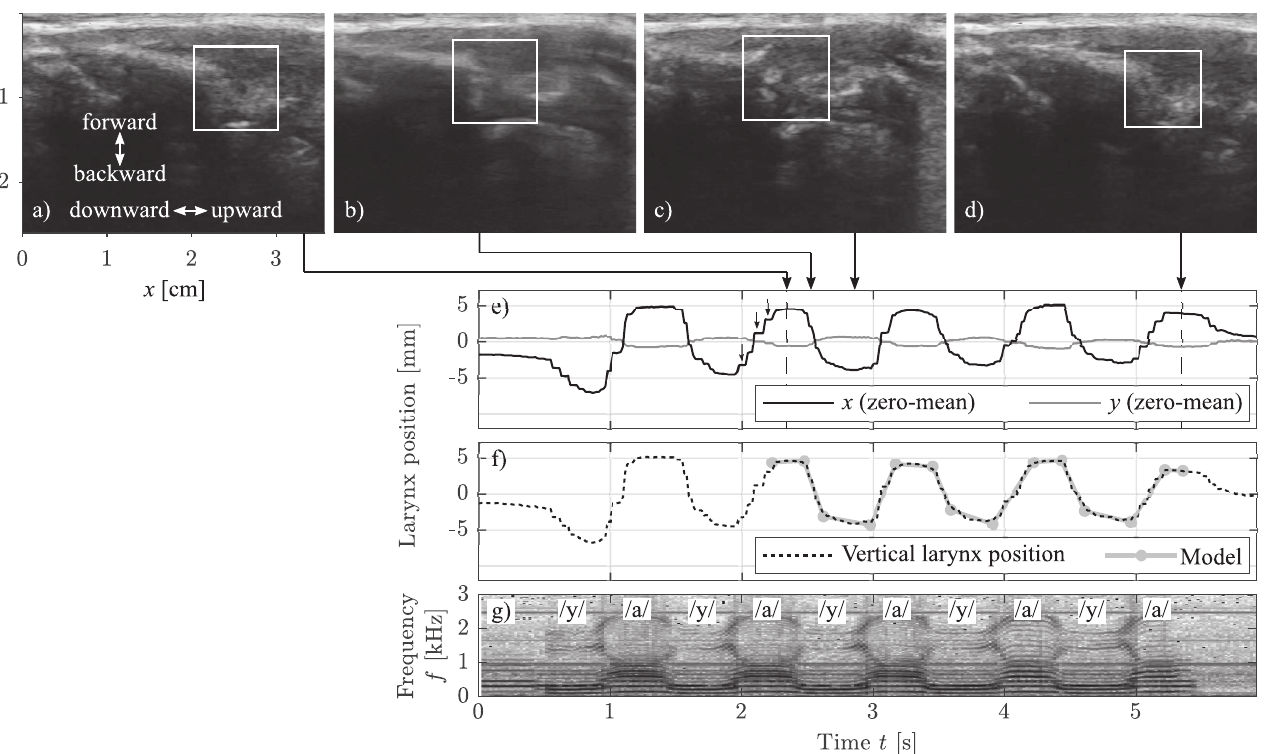
Fig 2. The consecutive data processing steps, illustrated by means of the utterance /y-a-y- ... / of subject M02 at the slow speaking rate, where each /a/ was uttered at a high pitch and is associated with a raised larynx, and each /y/ was uttered at a low pitch and is associated with a lowered larynx. a–d) The tracked region (white rectangle) in the ultrasound image during /a/ after the sequence start, during the transition from /a/ to /y/, during /y/, and during /a/ at the sequence end, respectively. e) The x -component (black curve) and the y -component (gray curve) of the vertical larynx movement were determined as the center coordinates of the tracked region over time. The artifacts (arrows) result from the adaption of the ultrasound device frame rate to the VGA standard. f) The vertical larynx position (black dashed curve) and the fitted model of straight-line pieces (gray lines) with the optimized endpoint coordinates (gray circles). g) The annotated spectrogram of the time-synchronous